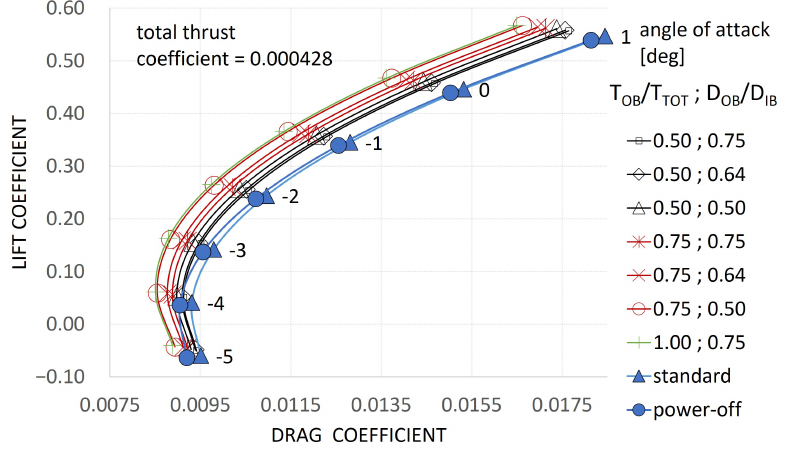
Figure 8. Drag polar curves: effect of IB and OB propellers at constant total thrust coefficient, cruise conditions ( M = 0.480; Re = 16.6 × 10 6